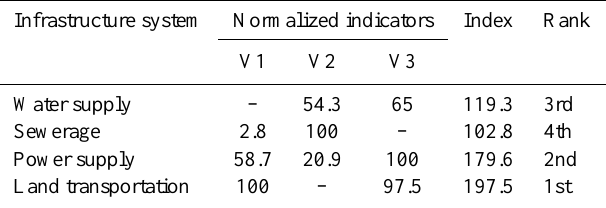
Table 7. Vulnerability